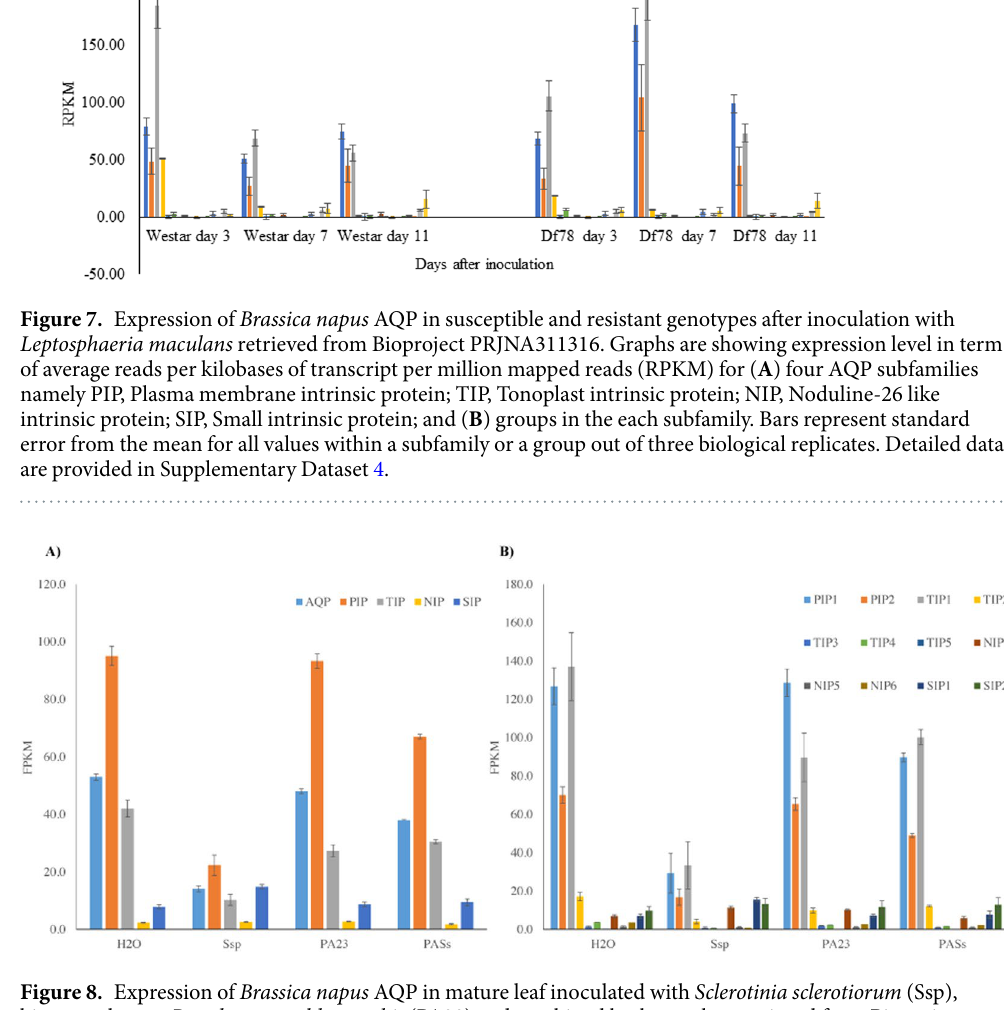
NPA motifs were located based on manual evaluation of protein sequence alignment. Several different amino acid compositions at NPA motifs were observed in B . napus that included: N-P-V, N-P-S, N-P-L, N-P-C and N-P-T. Amino acid sequence variation at NPA motifs was uniformly observed across AQPs identified in the seven species (Supplementary Tables 6–11). For instance, all the NIP5 homologs identified in seven species have conserved